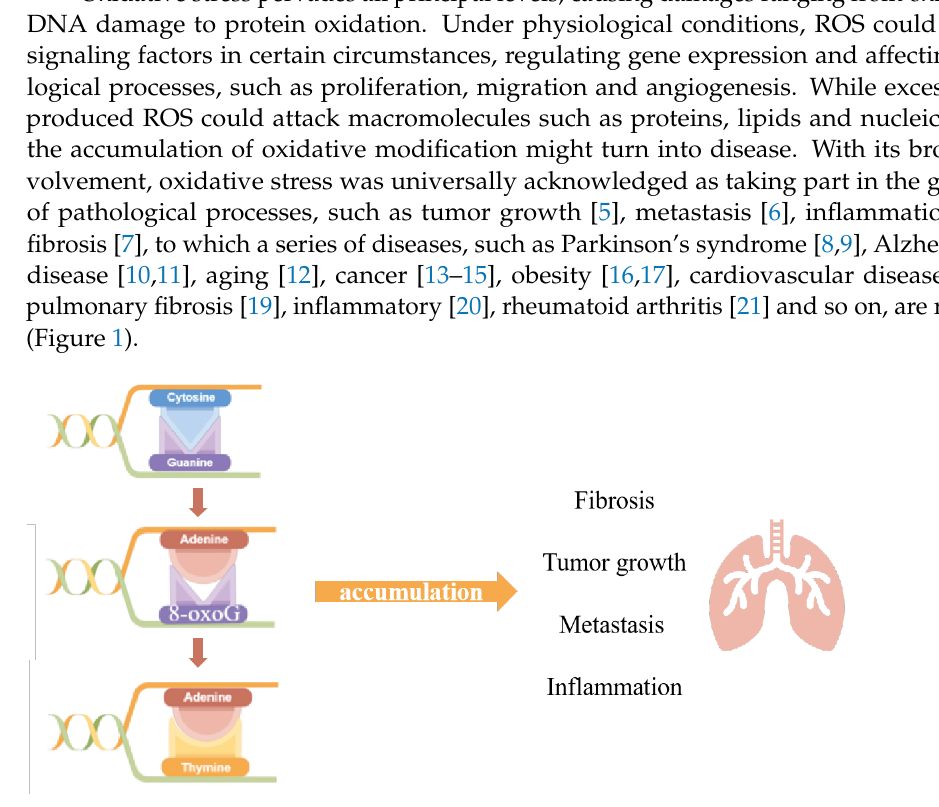
Figure 1. After oxidative stress attack, 8-oxoG is the most common form of bases which could mis-match with Adenine. The Adenine mismatched with 8-oxoG would match with Thymine after the normal DNA replication cycle, generating the transformation from GC-TA. Accumulation of such a transformation could lead to pathological processes, such as fibrosis, tumor growth, metastasis and inflammation. (drawn by Figdraw).